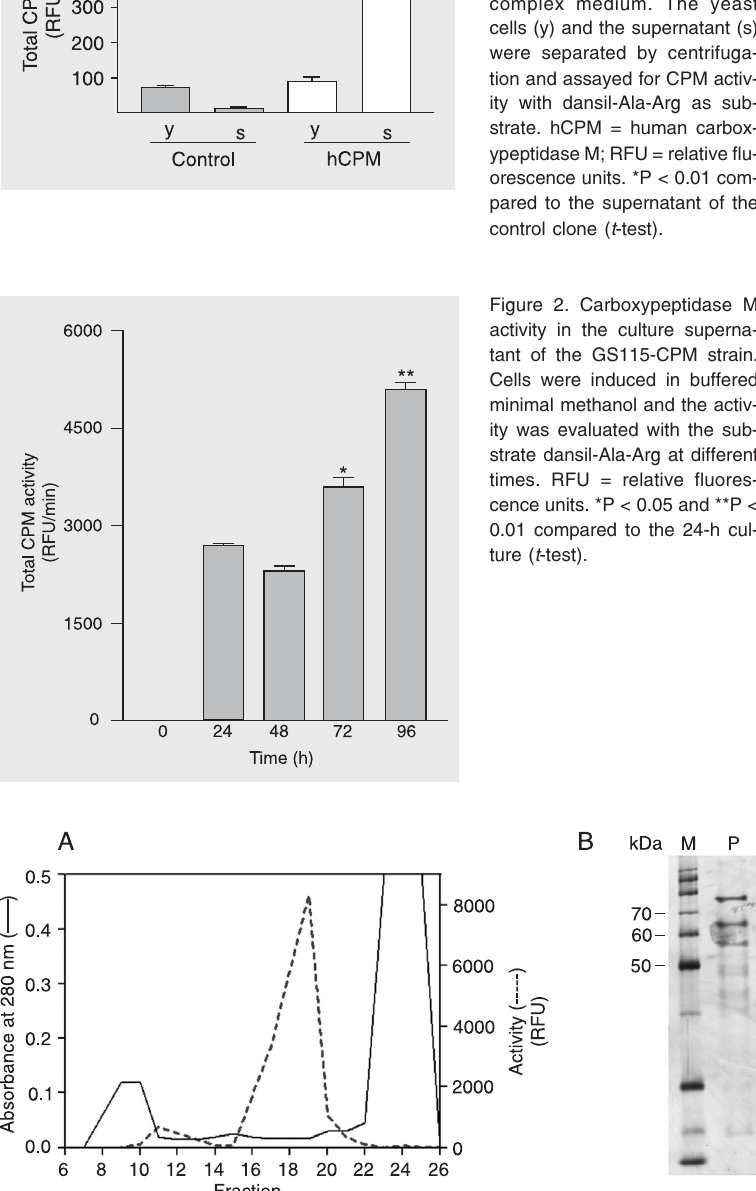
Figure 3. A , Gel filtration of recombinant human carboxypeptidase M (CPM). The concen- trated supernatant (3.05 mg/mL in 2 mL) was loaded onto a Superdex 200 HR 10/30 column in the FPLC system. The column was equilibrated with 50 mM Na-phosphate buffer, pH 7, containing 0.15 M NaCl and eluted with the equilibration buffer at a flow rate of 0.8 mL/min. Fractions of 0.5 mL were collected and assayed for CPM activity. RFU = relative fluores- cence units. B , SDS-PAGE (12%) of pooled fractions containing CPM activity (P). M, molecular mass markers (Bench Mark Protein Ladder,